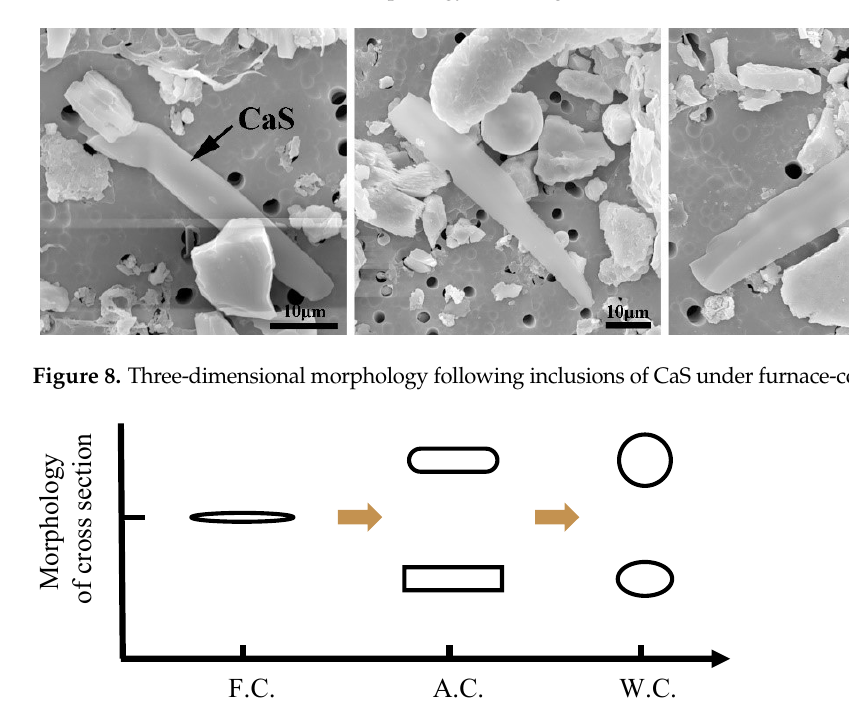
Figure 7. The three-dimensional morphology following inclusions of CaS under air-cooling conditions.